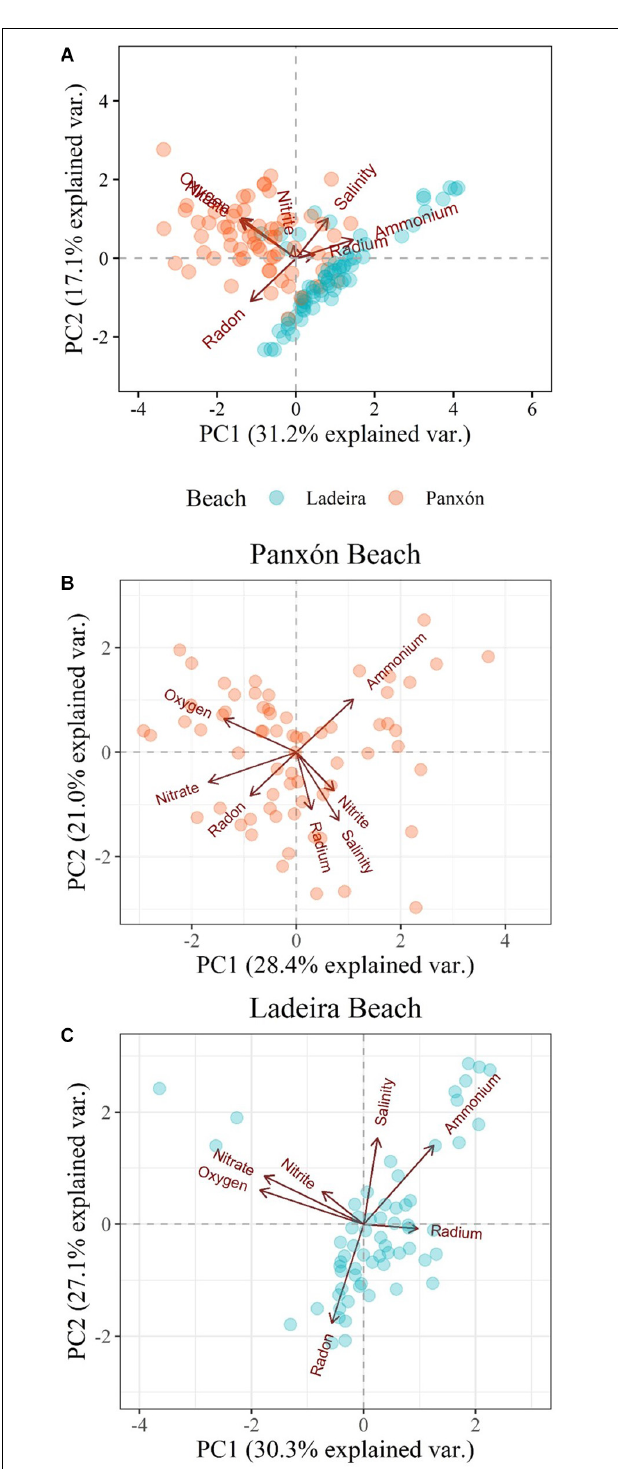
FIGURE 6 | (A) Principal Component Analysis (PCA) performed with the data from both beaches, identified with different colors. Components 1 and 2 were linearly correlated in both beaches: Ladeira: y = − 1 . 12 + 0 . 751x, R 2 = 0 . 68; Panxón: y = 0 . 288 − 0 . 288x, R 2 = 0 . 093. (B) PCA performed with the data from Panxón beach. (C) PCA performed with the data from Ladeira beach. Radon and Radium refer to 222 Rn and 226 Ra